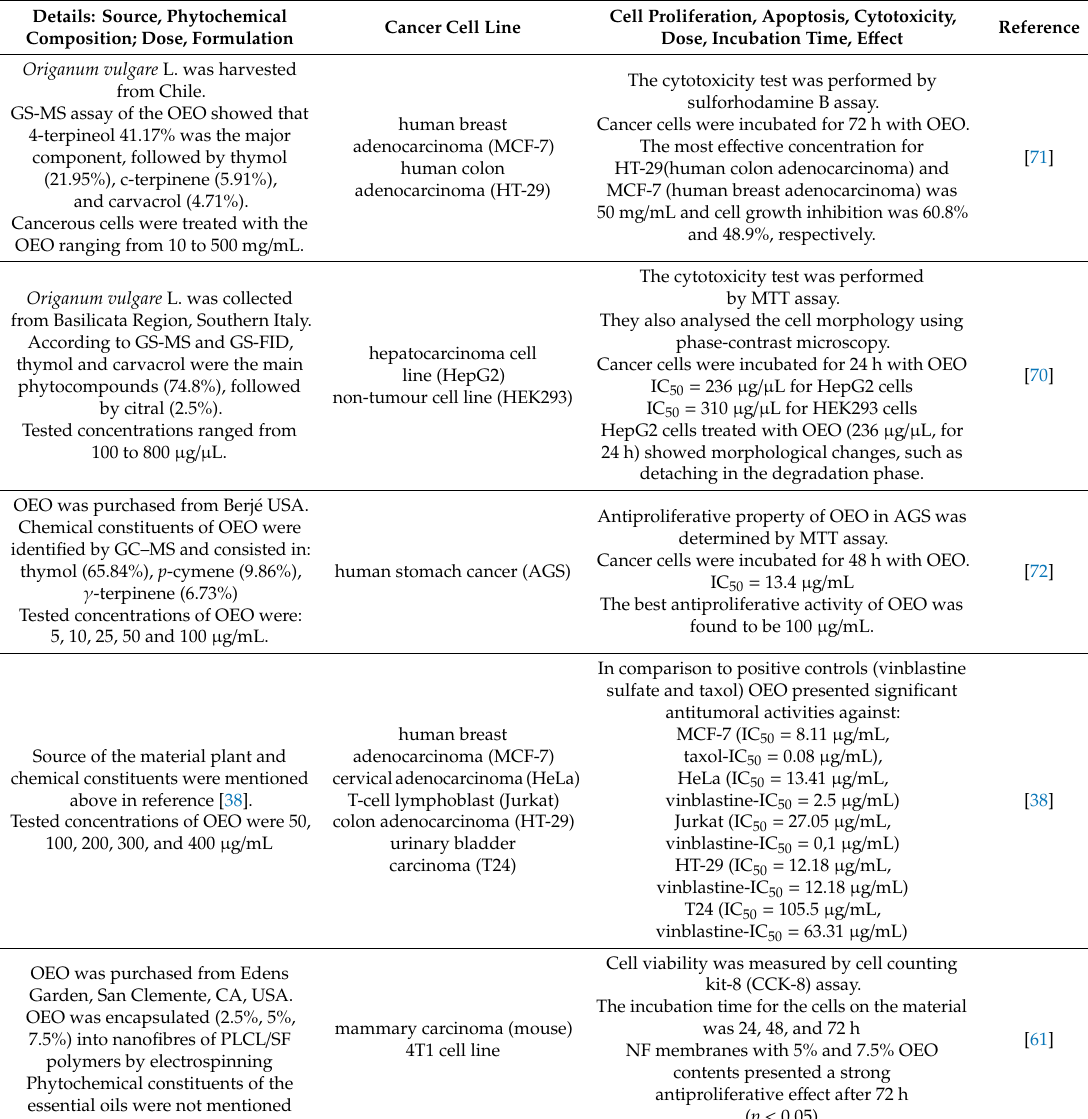
Table 7. In vitro anticancer activity of Origanum vulgare L. essential oil